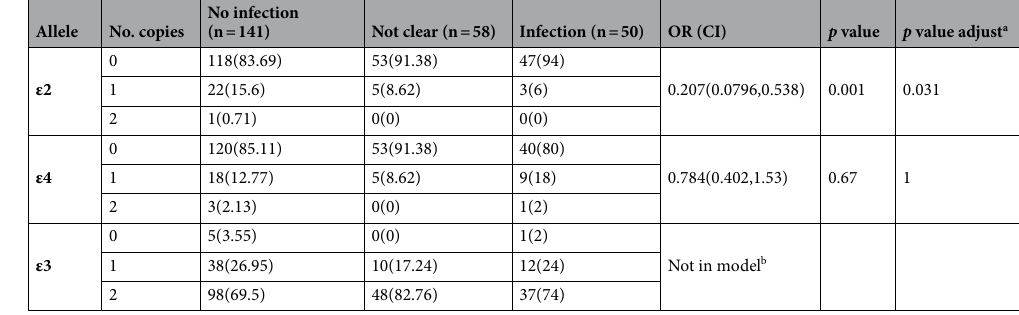
Table 3. Association of SARS-CoV-2 Infection and APOE alleles according to additive allelic models. Adjusted by sex, age, risk factors, virus exposure, severity, tobacco consumption, and arterial hypertension. a Corrected by multiple comparisons by Bonferroni test. b This allele is not included as it would result in perfect